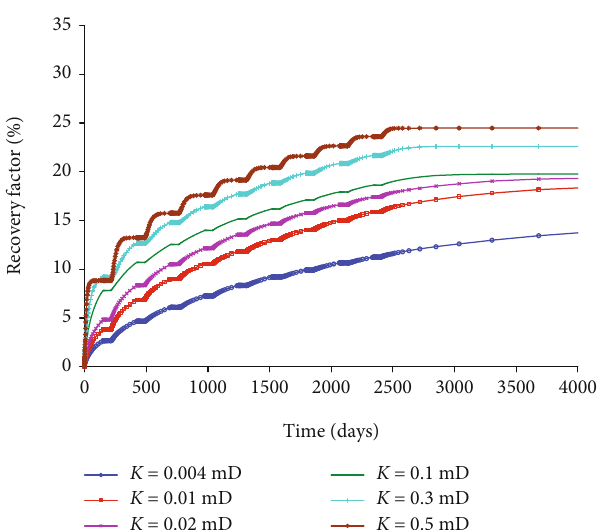
Figure 7: Production curves of reservoirs with di ff erent capillary pressure multipliers by cyclic surfactant injection.